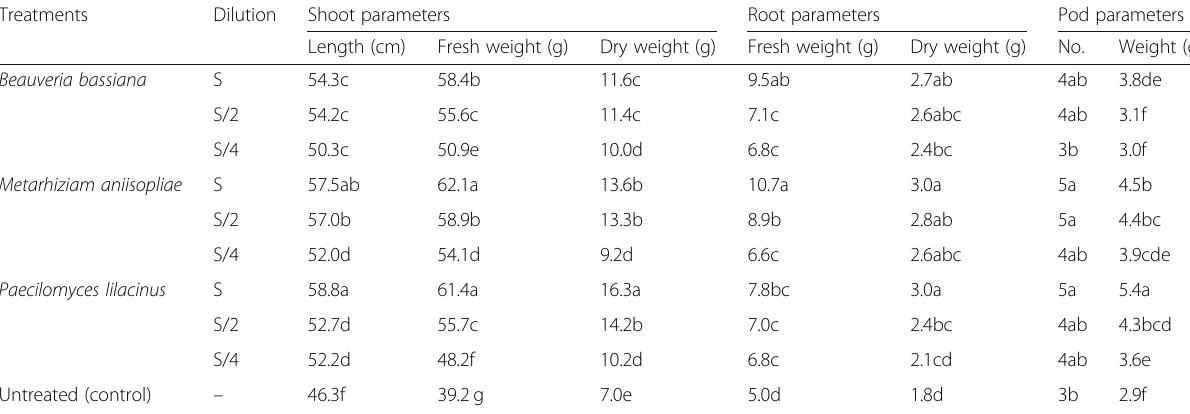
Table 8 Effect of three fungal filtrates from Beauveria bassiana , Metarhiziam aniisopliae , and Paecilomyces lilacinus on vegetative parameters and yield of cowpea infected by root-knot nematode, Meloidogyne incognita Treatments